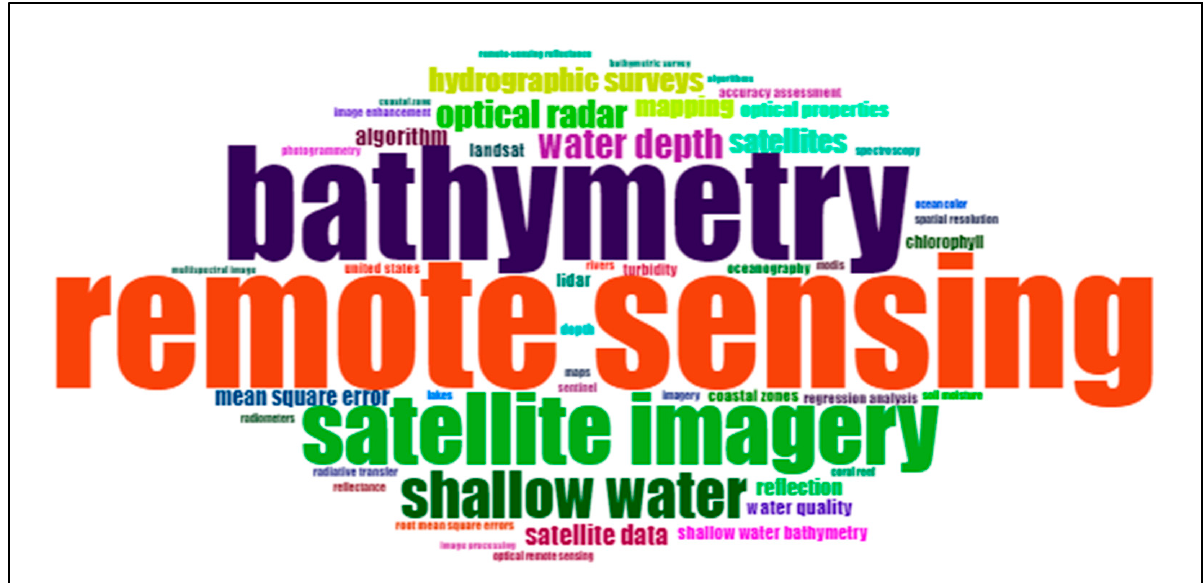
Figure 16. Word cloud of fifty most-occurring Keywords Plus for SDB (WoSCC and Scopus databases, from 1977 to 2022).